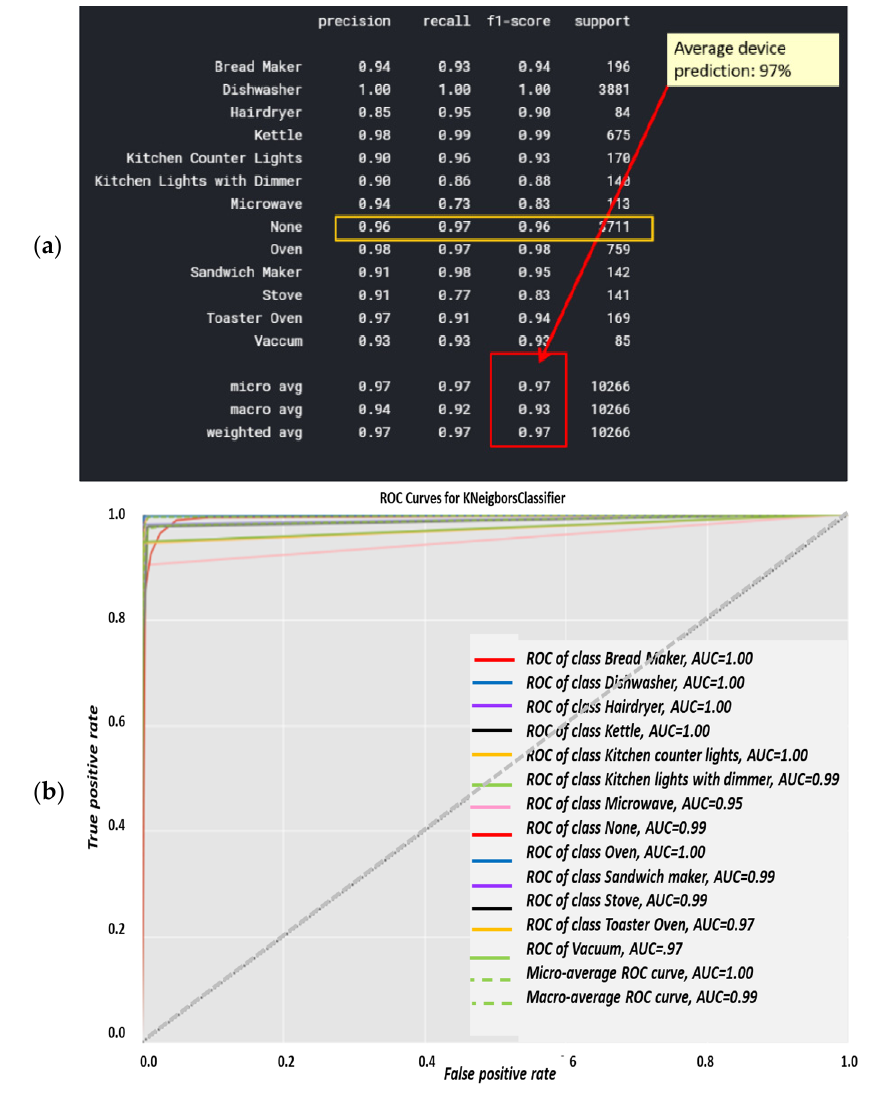
Figure 9. KNN ( a ) classification report and ( b ) AUC-ROC curves for each of the 13 electrical devices. Using vector algebra and electrical knowledge in Section 2.7 and then the 1 𝑟 (cid:2870) ⁄ dis-